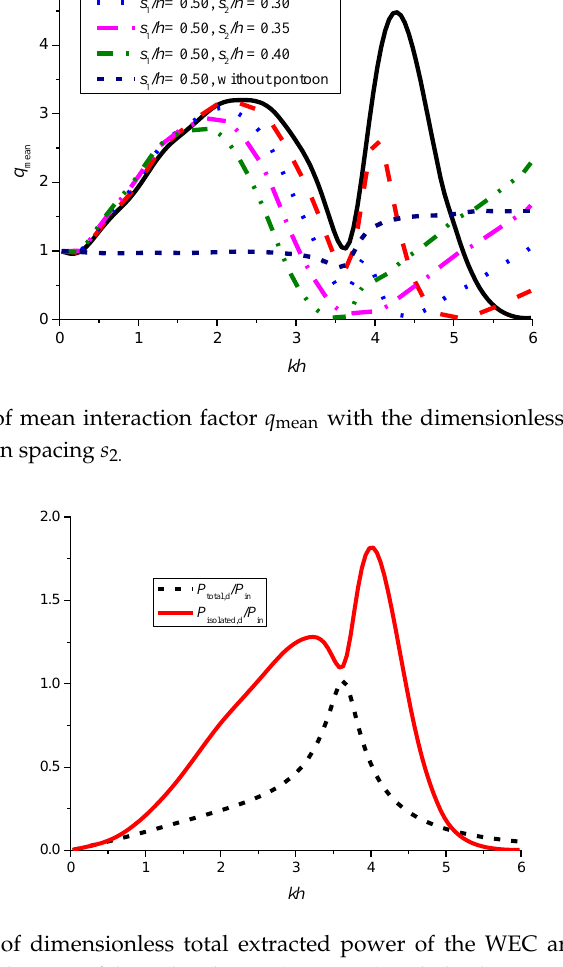
( μ nn / ρπa 2 d ) and the damping coefficient ( λ nn /ρωπa 2 d ) of individual devices for both the isolated and